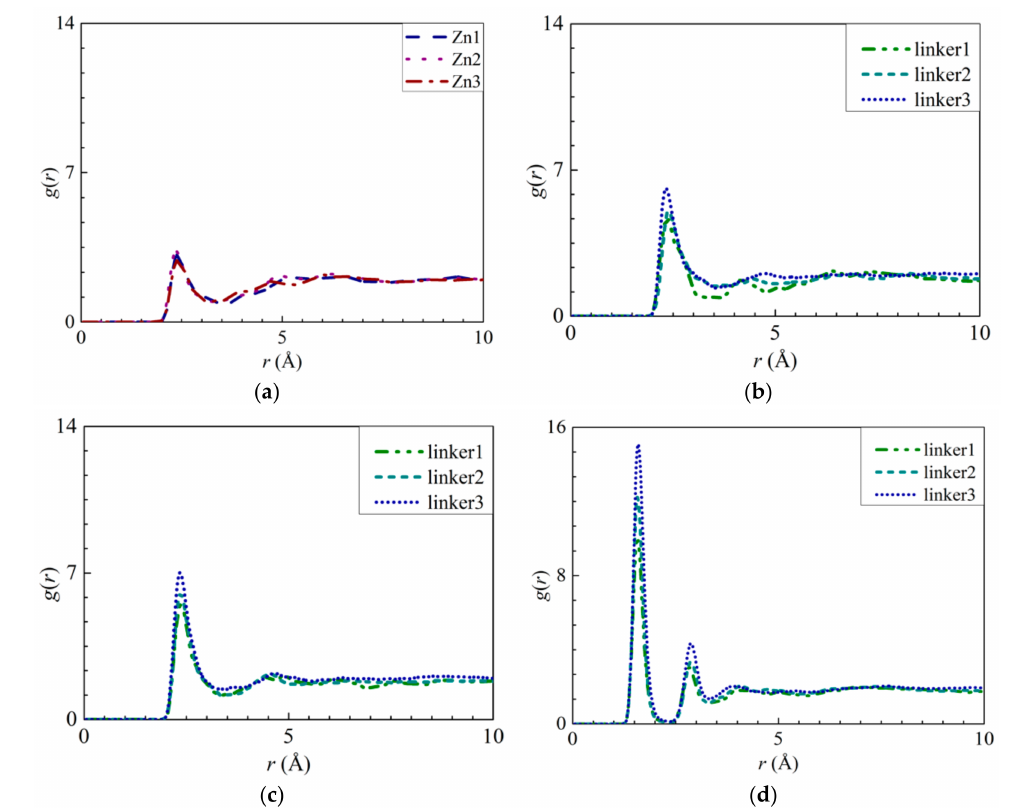
Figure 12. RDFs of the O atoms of water molecules around the atoms at the respective defect sites: ( a ) H3 atoms at the Zn substitutional defect site, ( b ) H3 atoms and ( c ) H4 atoms at the linker substitutional defect site. ( d ) RDF of the hydrogen atoms of water molecules around the O2 atoms at the linker substitutional defect